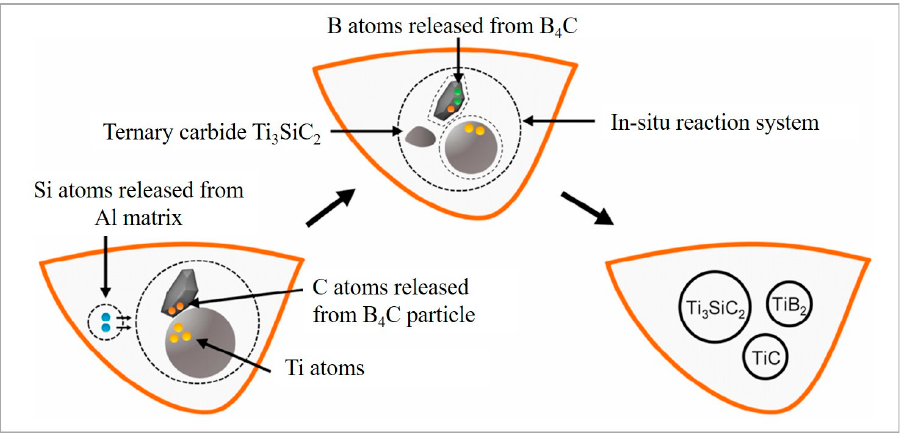
Figure 14. In situ formation mechanism of TiB 2 , TiC, Ti 3 SiC 2 ceramic phases in the molten pool (reproduced with permission from [94]). (reproduced with permission from